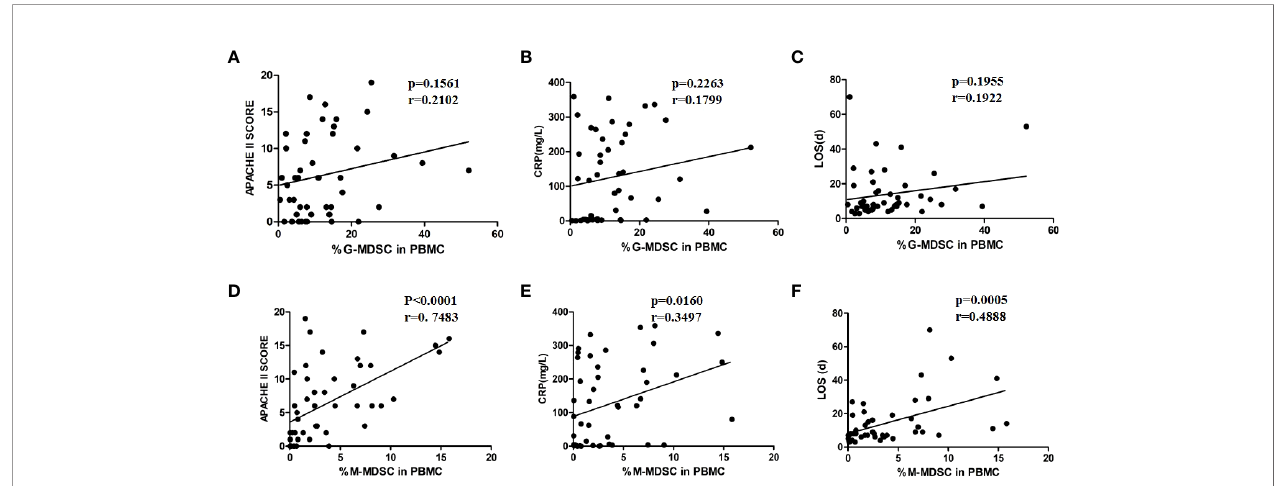
FIGURE 4 | M-MDSC frequency was associated with disease severity. The percentage of G-MDSC in PBMC was not correlated with APCHE II scores (A) , CRP levels (B) , or LOS (C) . The percentage of M-MDSC in PBMC was positively related to APACHE II scores (D) , CRP levels (E) , and LOS (F) .